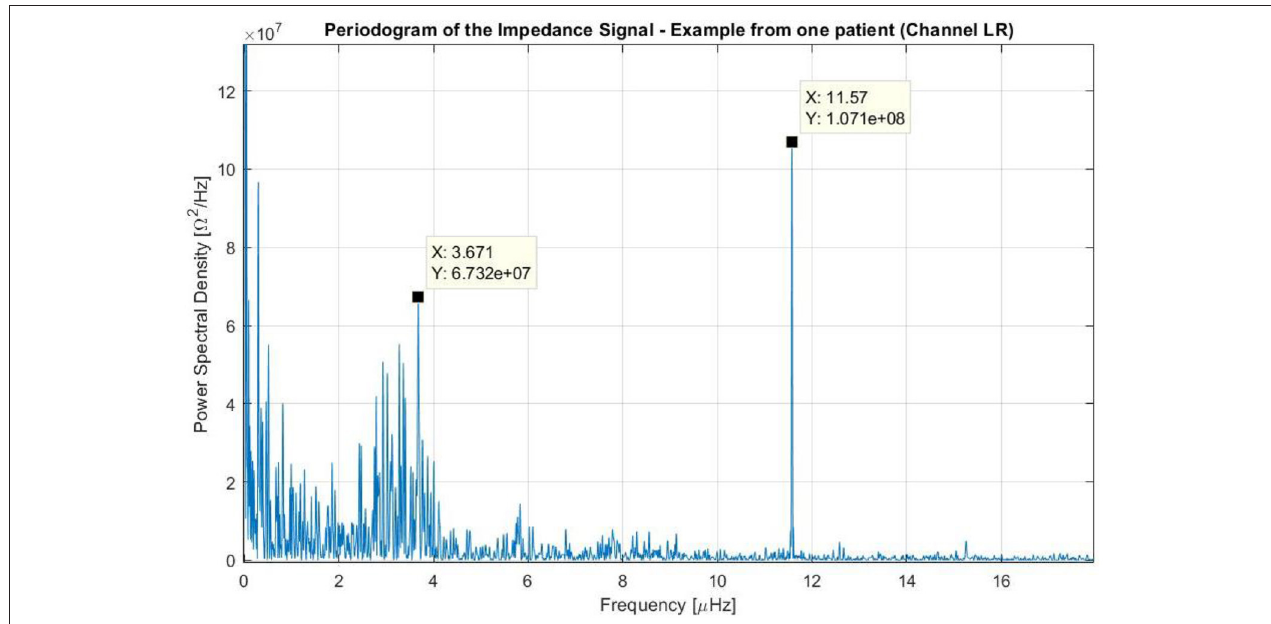
FIGURE 5 | Periodogram of the impedance using the data of one patient treated with TTFields who participated in the EF-14 clinical trial. The variation of the impedance throughout treatment was caused by three main factors: (1) one that occurred at frequencies near the 0Hz (i.e., long-term variations); (2) one that occurred at frequencies around 3.7 µ Hz (which corresponds to a periodicity of around 3 days); and (3) one that occurred at a frequency around 11.6 µ Hz (24h).